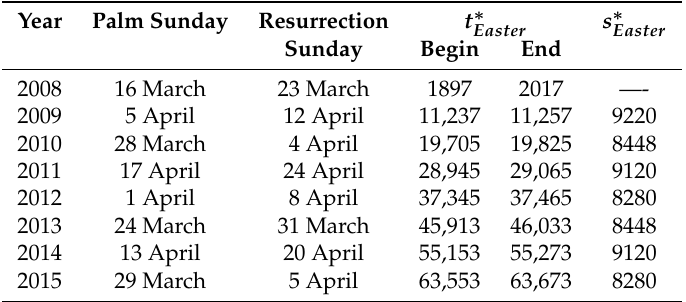
Table 2. General Easter period in